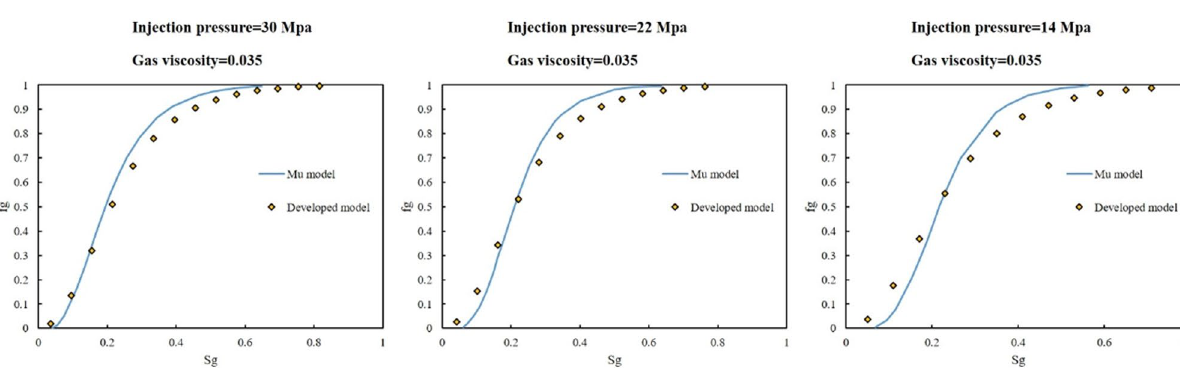
Figure 3. Comparison of simulated value of fractional flow at gas viscosity of 0.035 mPa s three injection pressures of 30, 22, and 14 MPa with the results of Mu et al. 43